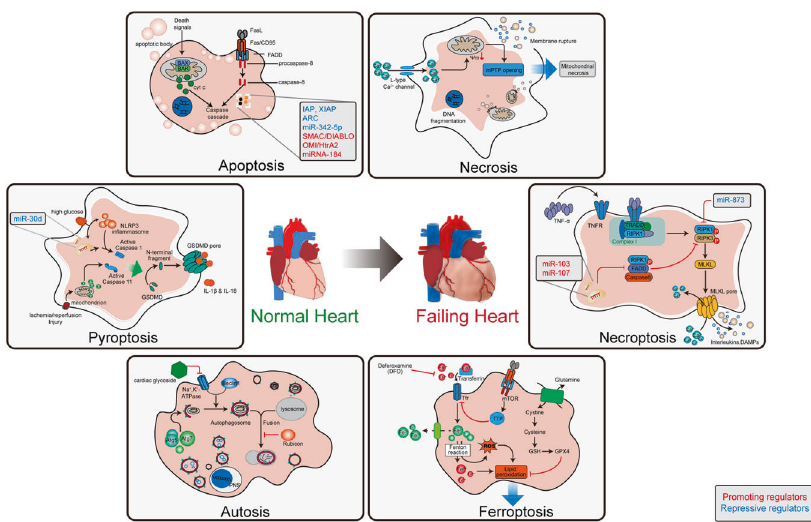
Fig. 3 Non-programmed and programmed cardiomyocyte death in failing heart. Cardiomyocyte death contribute to loss of myocardium, especially after ischemia injury. Different types of programmed cell death are controlled by their speci fi c signaling pathway. Modulating programmed cell death by targeting their signaling pathway can attenuate cardiac dysfunction after ischemia injury. BAX: BCL-2-associated X protein; BAK: BCL2-antagonist/killer 1; cty C: Cytochrome C; FADD: Fas associated death domain; FasL: Fas ligand; TNF- α : tumor necrosis factor α ; TRAIL: TNF-related apoptosis inducing ligand; IAP, Inhibitor of apoptosis; ARC: Apoptosis repressor with caspase recruitment domain; mPTP: mitochondrial permeability transition pore; TNFR: TNF receptor; TRADD: TNFR1-associated death domain; RIPK1: serine/threonine kinases receptor interacting protein kinase 1; MLKL: mixed lineage kinase-like domain; DAMPs: damage-associatedmolecularpatterns; GSDMD: gasdermin D; PNS: perinuclear space; Atg5: Autophagy related 5; Atg3: Autophagy related 3; Tfr: transferrin receptor; TTP: tristetraprolin;